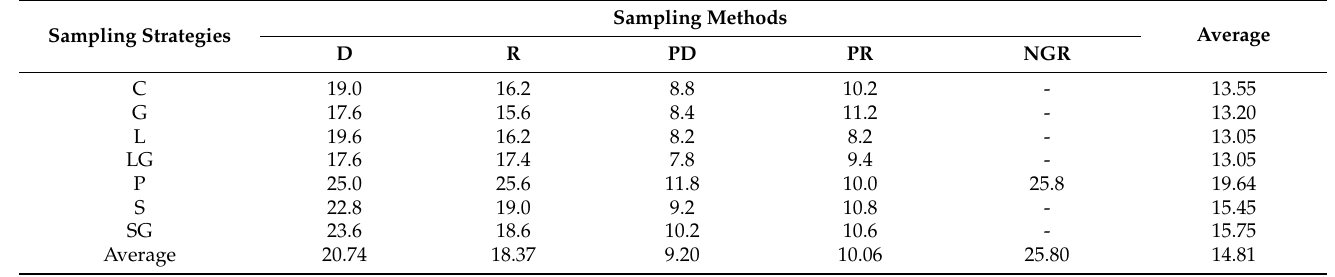
Table 5. Comparison of the average ranking scores of the five parameters for sampling strategies with